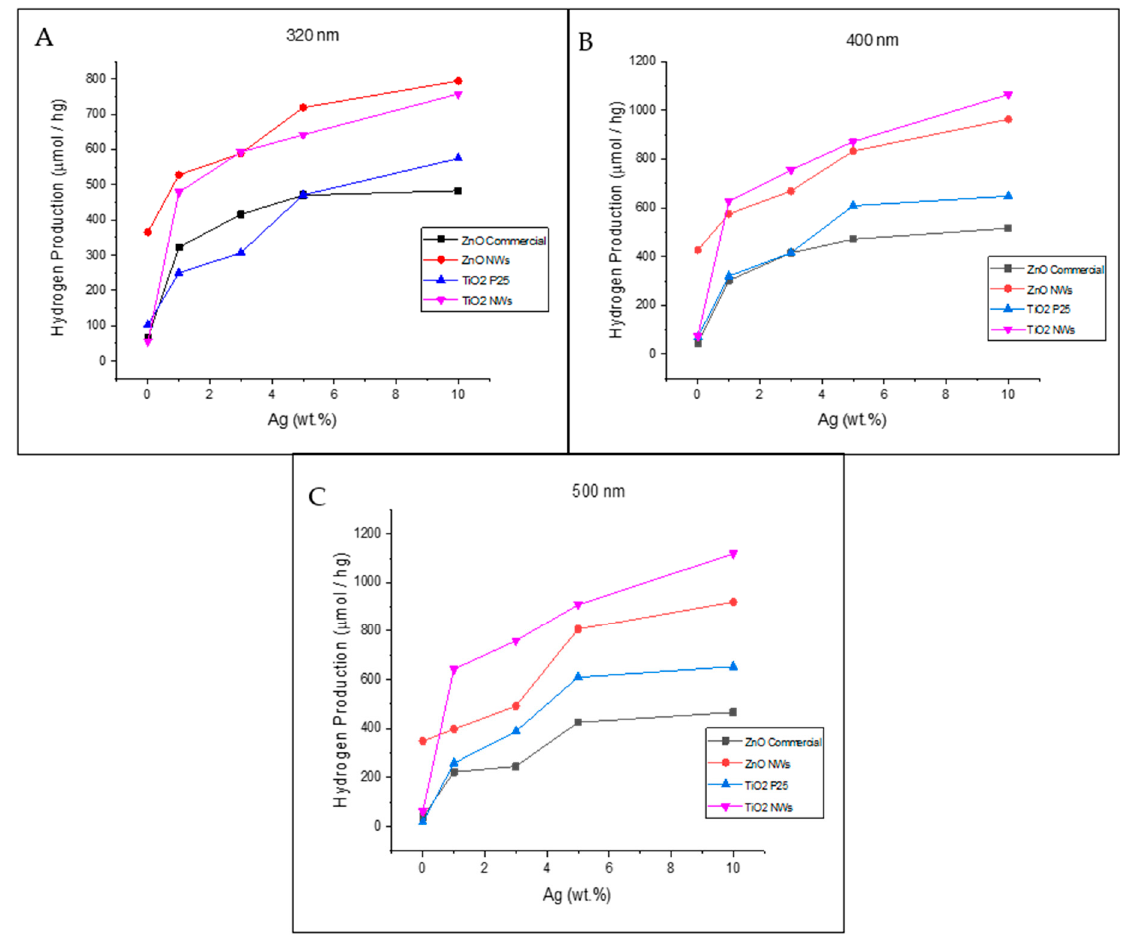
Figure 7. Photocatalytic hydrogen production of the different silver-based catalysts under irradiation at 320 ( A ), 400 ( B ), and 500 nm ( C ).